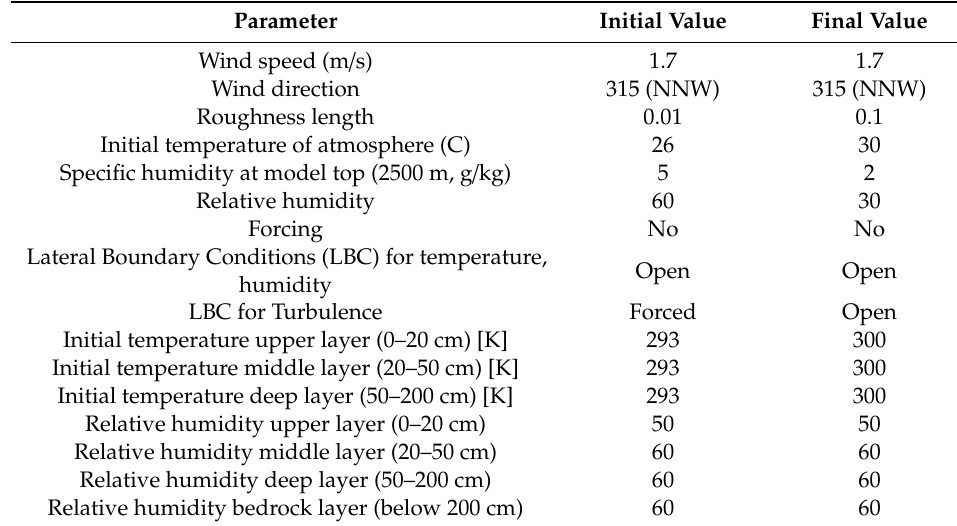
Table 3. Input and output parameters used in model calibration and resulting values. This table represents the calibration of Cluster 3 (MCN) and serves as a sample for reference, though similar tables were generated for all six cluster types.